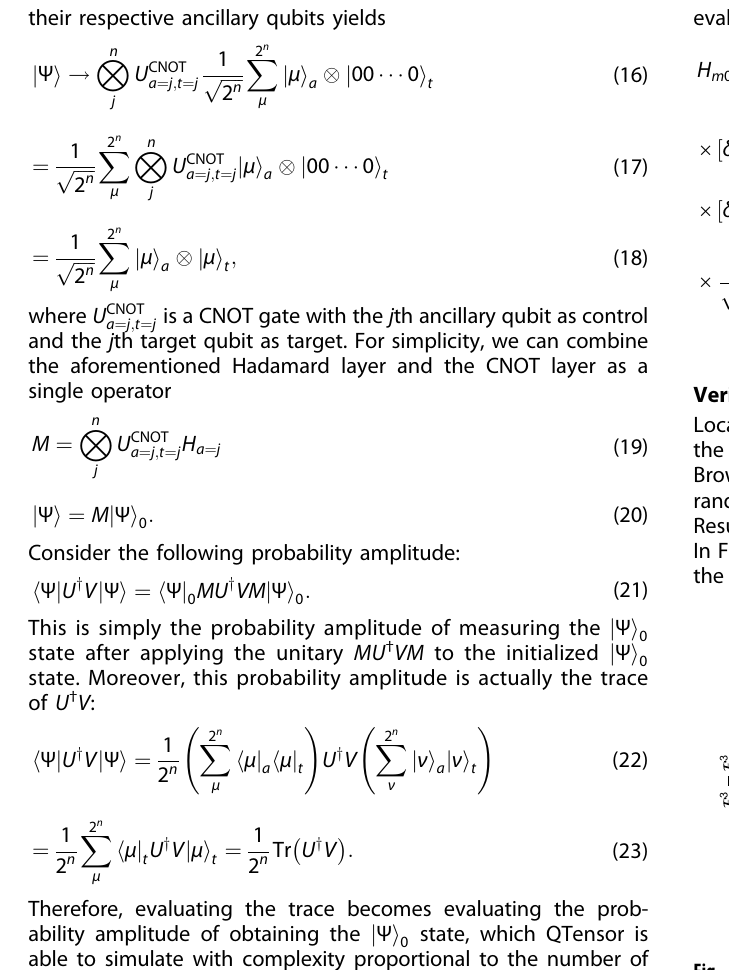
Fig. 4 Fractional deviation of the k = 3 frame potential from the Haar value as a function of layers for the parallel random unitary ansätz. As shown in Fig. 1, we do not expect linear scaling of l in n with fi xed F . Error bars show one standard error.